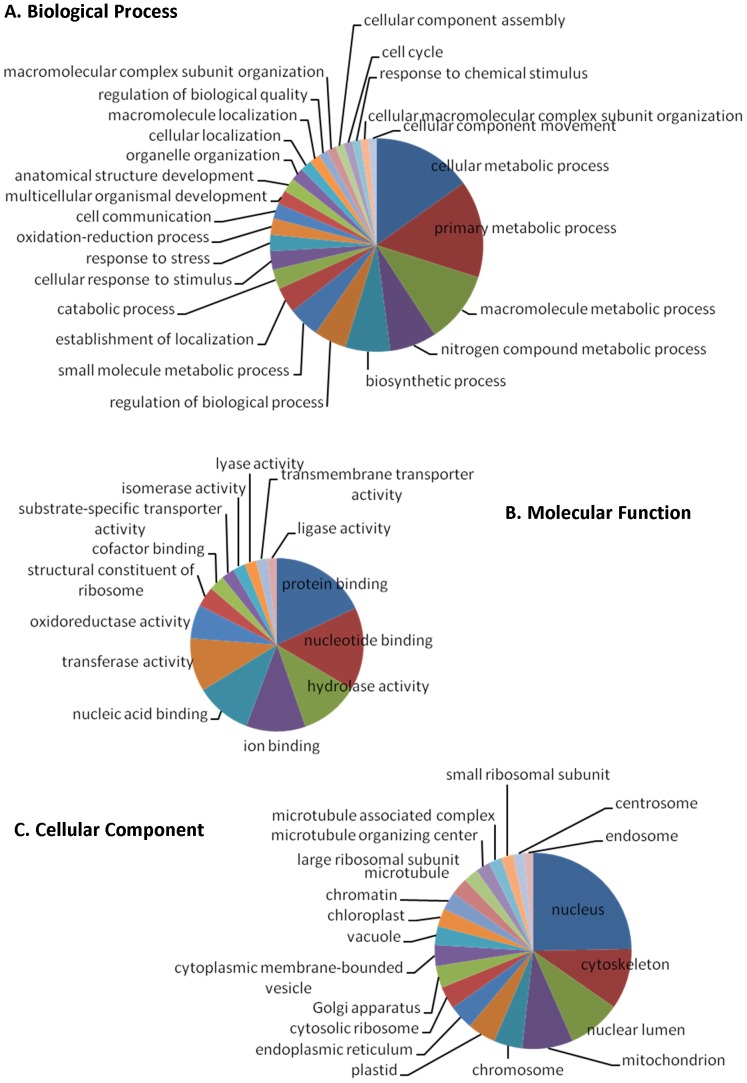
Functional distribution of Eutreptiella sp. transcriptomes.The pie charts were generated at level 7 for cellular component and level 3 for biological process and molecular function by using Blast2Go.